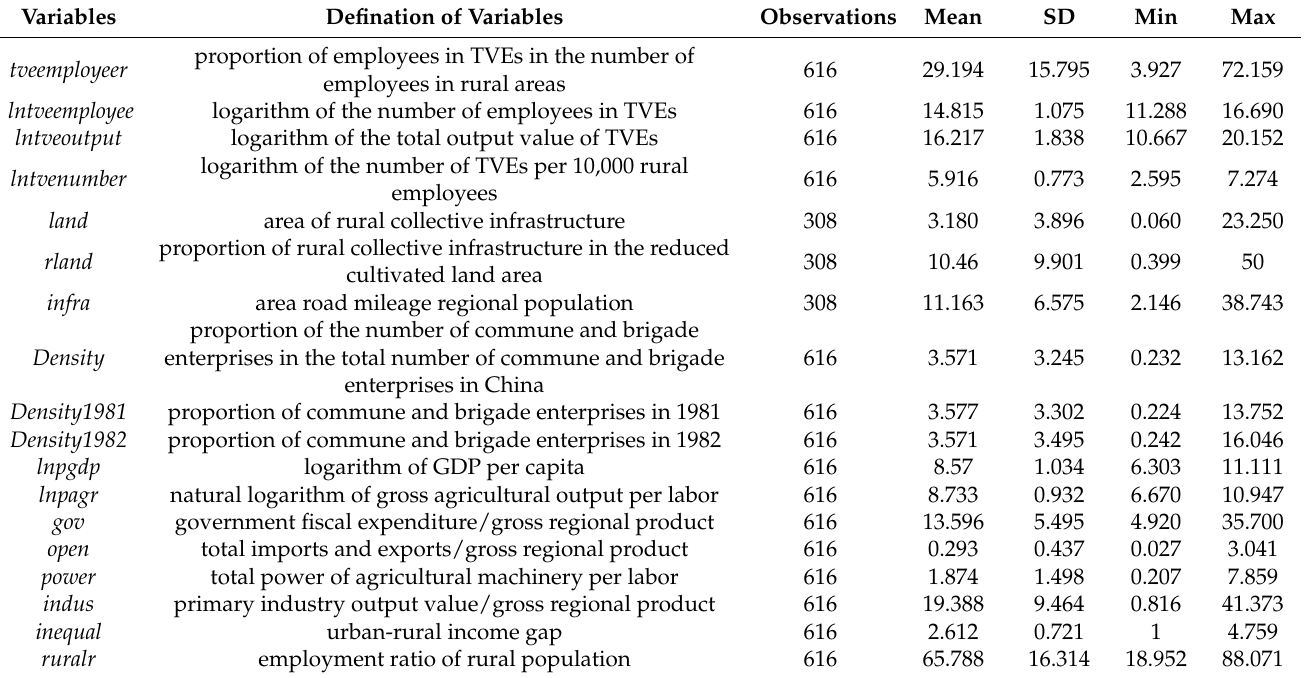
Table 1. Variable description and descriptive